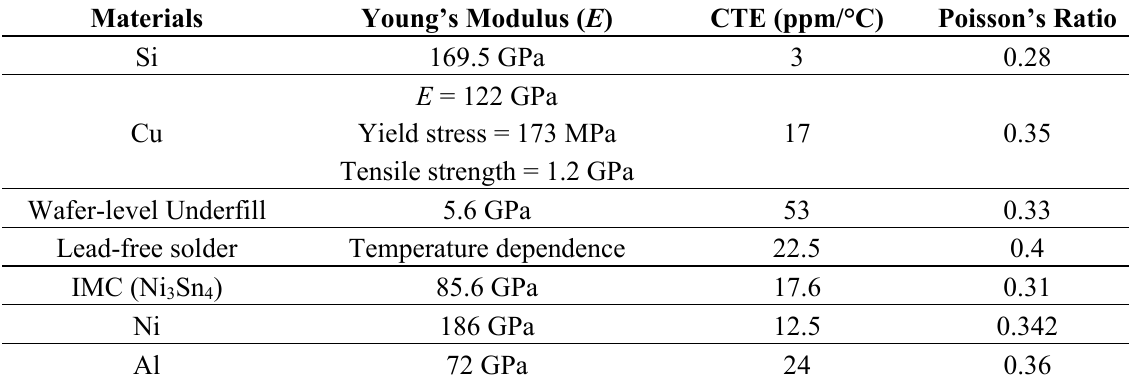
Figure 6. Finite element model of 3D chip stacking with WLUF when equivalent materials of the microbump unit are introduced into the internal part of the packaging structure. Table 4. Material properties used in 2D nonlinear